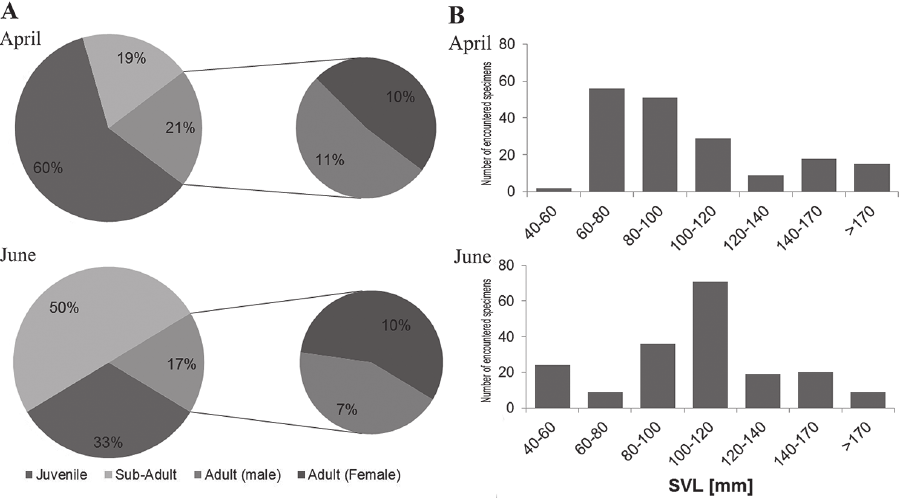
Figure 3. Population structure of Physignathus cocincinus from Thua Thien Hue Province, central Vietnam (April vs. June, respectively); B. Frequency histogram of snout-vent length of P. cocincinus for the months April and June, 2016 and